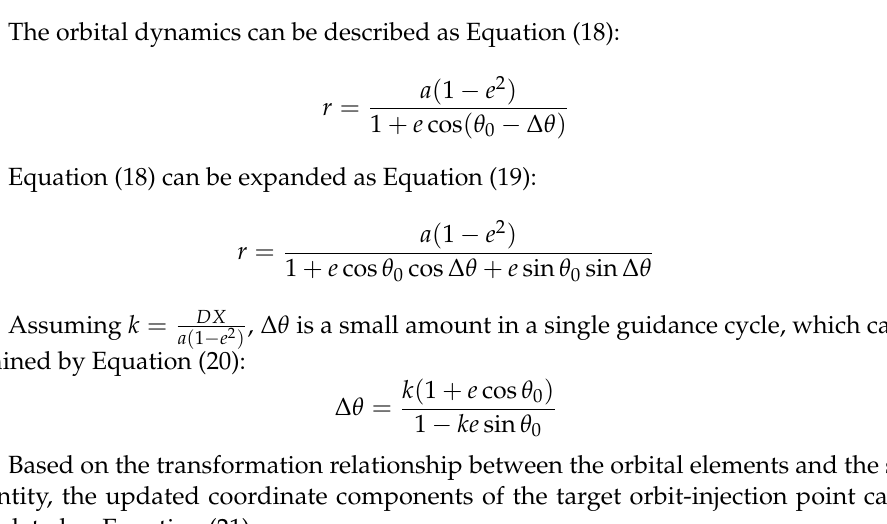
Figure 5. Schematic diagram of the adaptive target update algorithm.